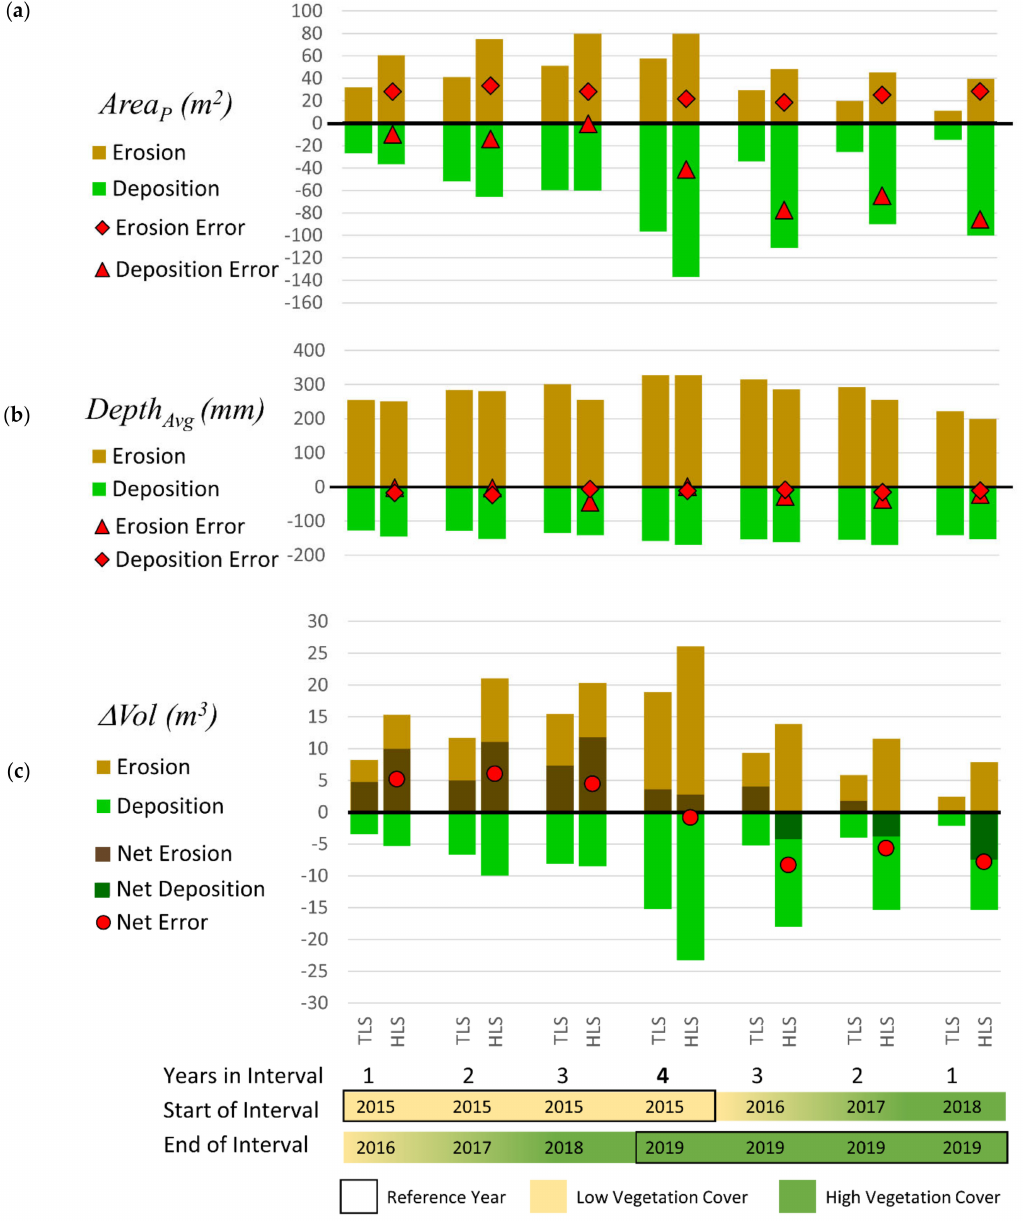
Figure 9. Comparison of TLS versus HLS in estimates of ( a ) depth, ( b ) planimetric area and ( c ) volumetric change for areas of erosion (positive/brown) and deposition (negative/green). Net Volumetric change (erosion minus deposition) for each interval are overlain in black on ( c ). Errors in estimation of net error are shown as red markers. Data used in this chart is provided in detail in Tables